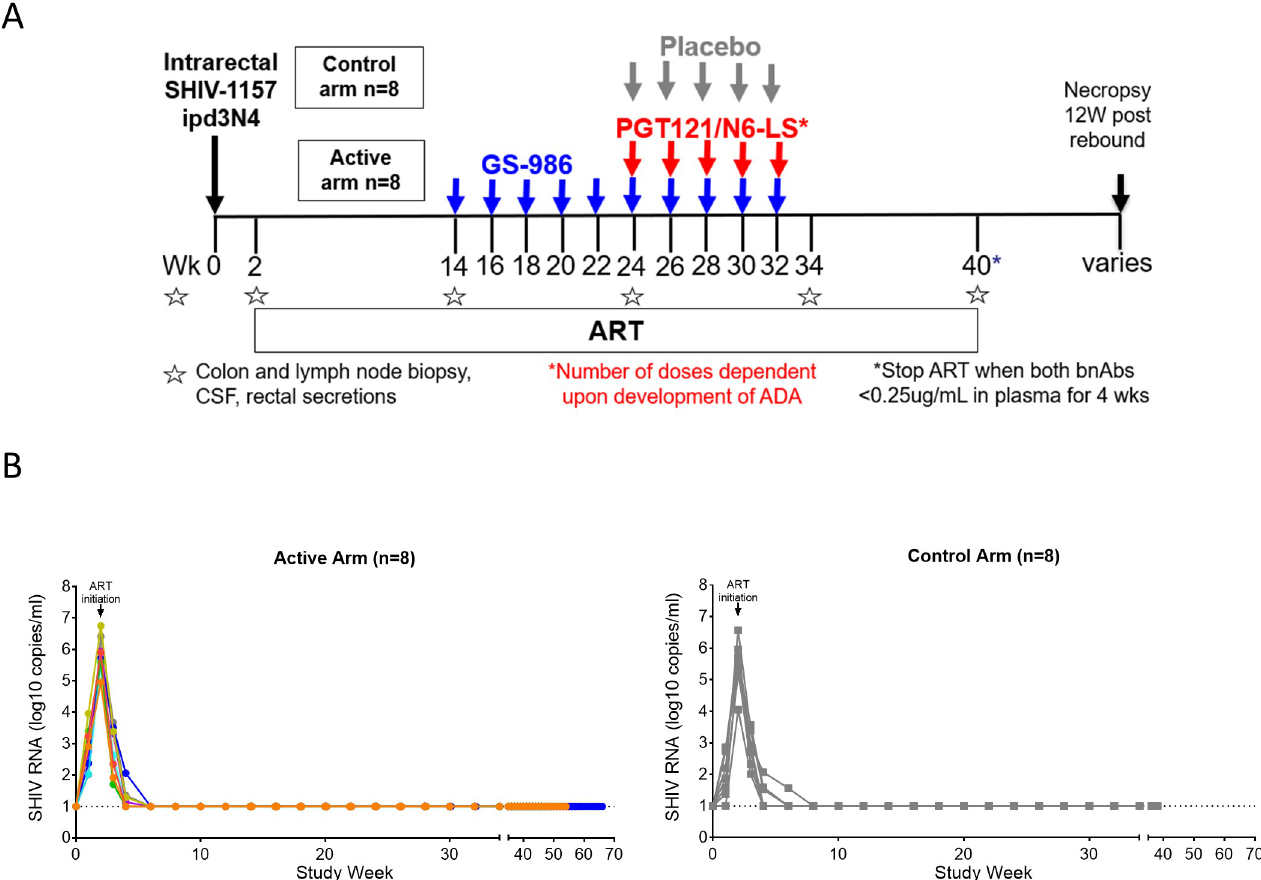
Fig 1. Study schema. (A) Male rhesus macaques (n = 16) were inoculated with SHIV-1157ipd3N4 intrarectally at wk 0. ART was initiated on day 14. Animals in the active arm (n = 8) received GS-986 every 2 wks from wk 14 and intravenous N6-LS and PGT121 every 2 wks from wk 24 to 32, unless anti-drug antibodies (ADA) developed. ART was ceased 4 wks after plasma levels of N6-LS and PGT121 were < 0.25 ug/mL. Animals in the control arm (n = 8) received normal saline every 2 wks from wk 24 to 32 and ART was ceased at wk 40. (B) Plasma SHIV RNA levels of animals in the active and control arms from the time of inoculation to immediately before ART interruption are shown. Data from animals in the active arm are displayed in color with each color corresponding to individual animals identified in Fig 4A. The x axis has been segmented to allow clearer visualization of viral dynamics during the first 34 wks post infection, when interventions were administered. Dotted line represents limit of quantification (LOQ) of SHIV RNA assay (10 copies/mL).